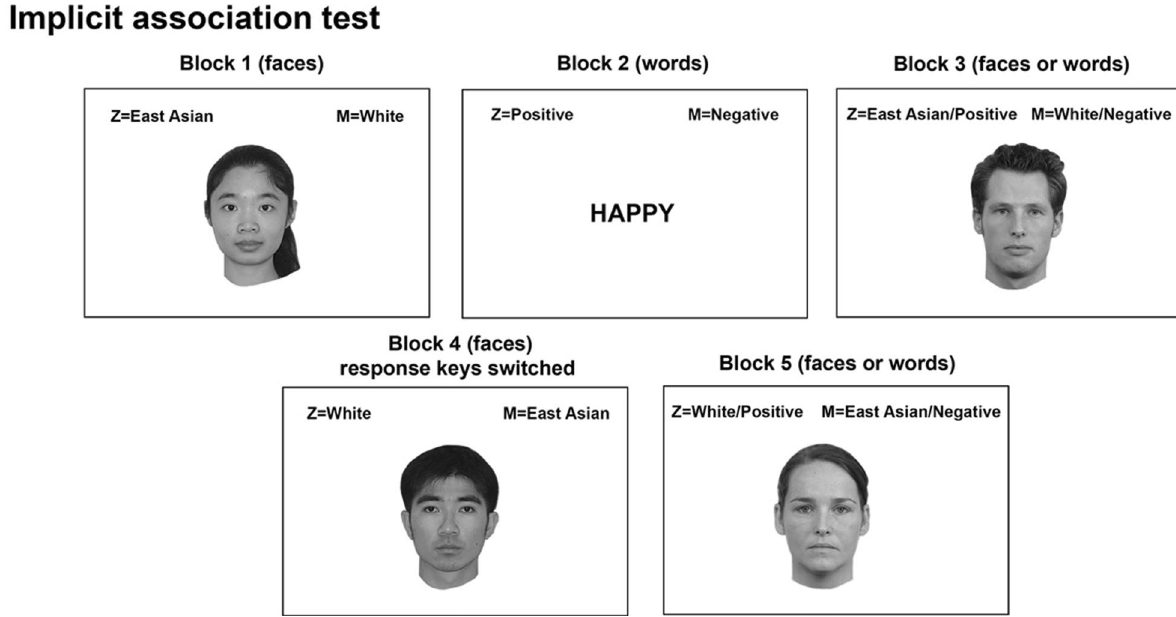
Fig. 2 Schematic procedure of the implicit association test (IAT). Participants categorized East Asian and White faces in Block 1, and positive and negative words in Block 2. In Block 3, participants categorized the faces and words presented in a random order. In Block 4, participants again categorized the faces with the response key mapping switched. In Block 5, participants again categorized the randomly presented faces and words